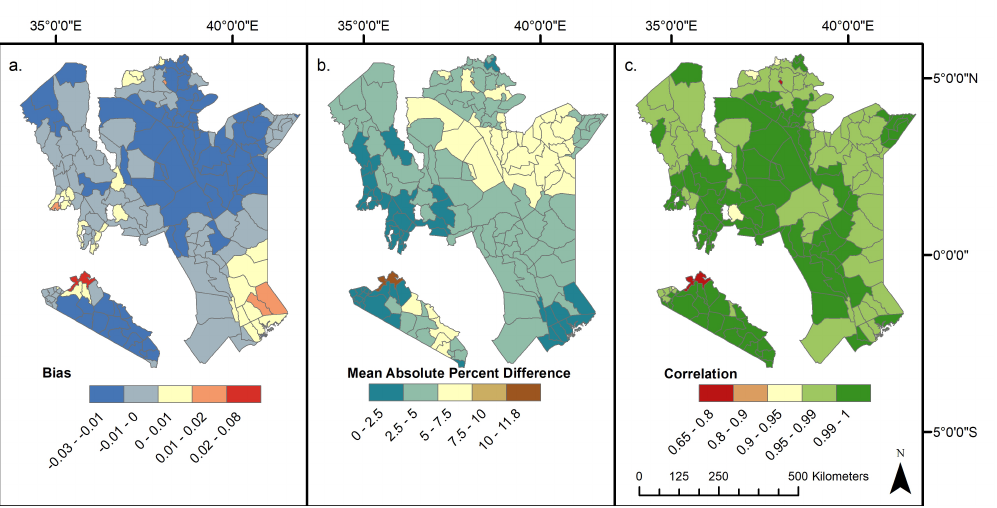
Figure 6. Bias ( a ), MAPD ( b ), and correlation ( c ) of mean monthly NDVI at the Unit Area of Insurance (UAI)